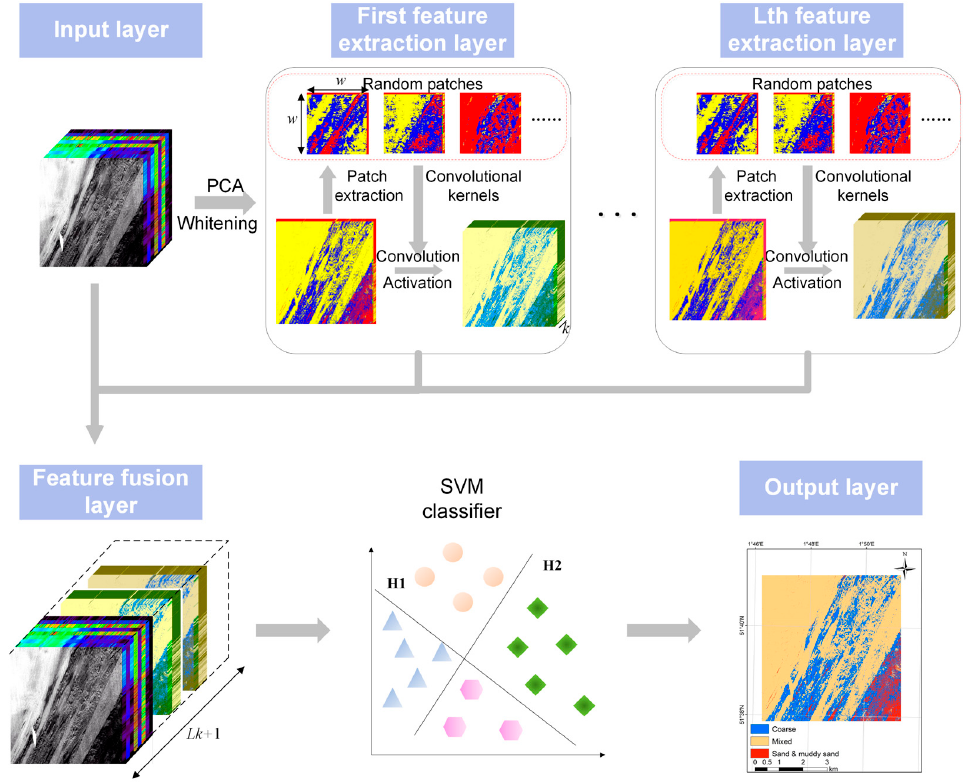
Figure 3. An overview of the RPNet framework.